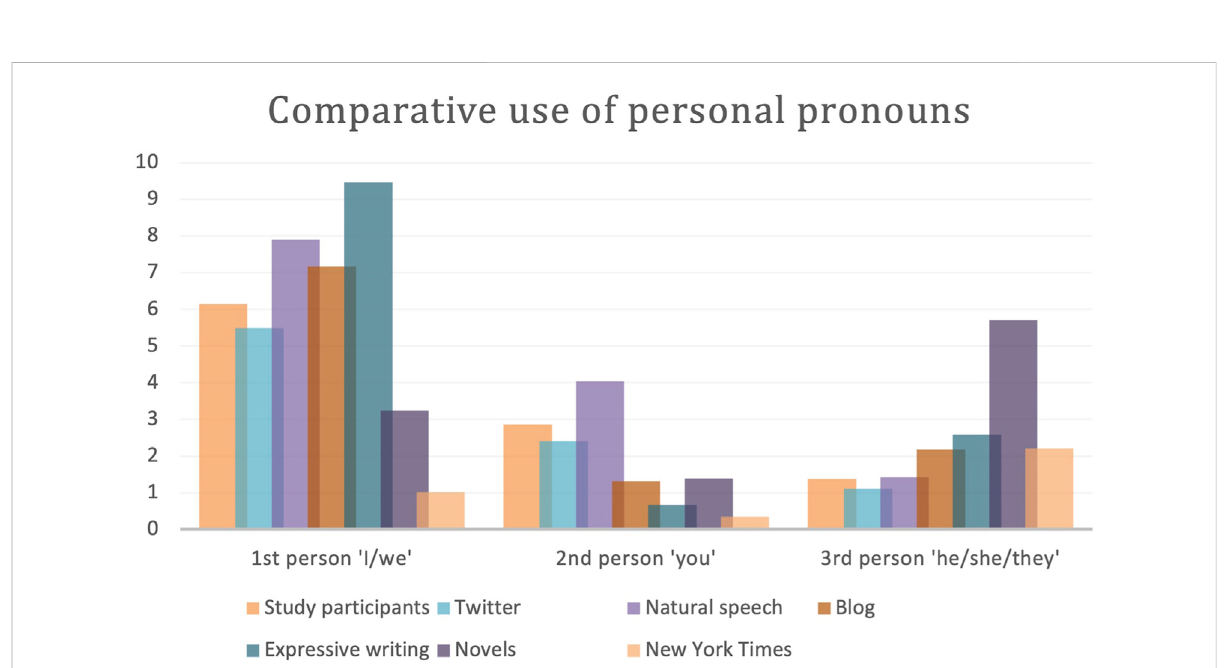
FIGURE 5 Chart illustrating comparative use of personal pronouns in different literary